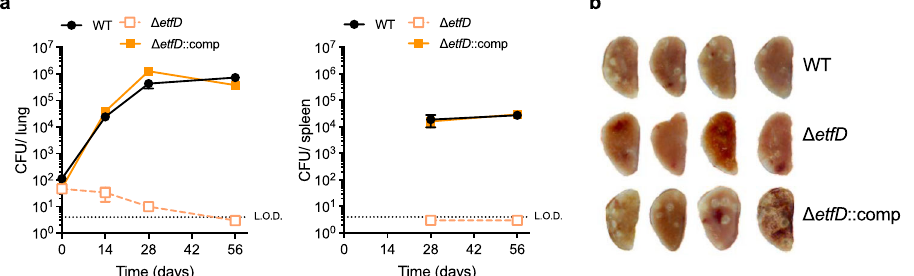
Fig. 2 EtfD is essential for growth and survival in vivo. a Growth and persistence of wild type Mtb, Δ etfD and the complemented mutant in mouse lungs and spleens. Data are CFU averages from four mice per time point and are representative of two independent experiments. Error bars correspond to standard deviation. “ Comp ” stands for complemented. L.O.D. stands for limit of detection. b Gross pathology of lungs infected with wild-type Mtb, Δ